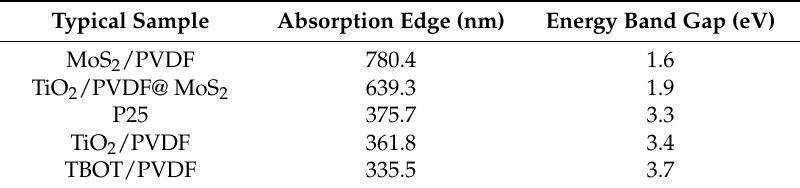
Table 1. The absorption edge and energy band gap for the typical samples.